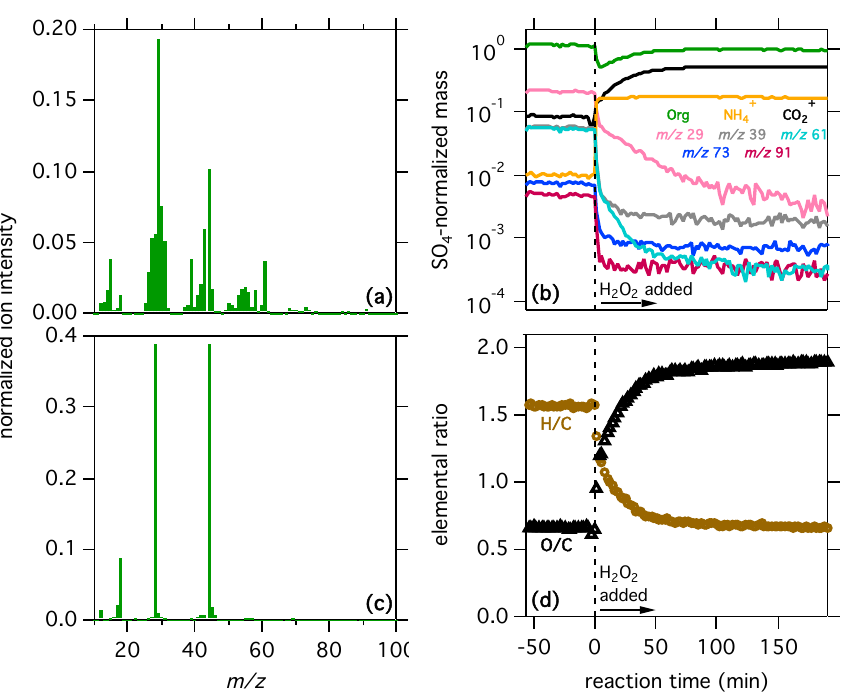
Figure 3. Results for the oxidation of erythritol within the bulk aqueous phase: (a) AMS spectra of unreacted erythritol; (b) sulfate- ) , CO + normalized mass concentrations of total organic (Org), ammonium (NH + , and key ions associated with erythritol ( m/z 29, 39, 4 2 61, 73, 91) as a function of reaction time; (c) AMS spectra of oxidation products; and (d) oxygen-to-carbon and hydrogen-to-carbon ratios as a function of reaction time. Results in (a, c, d) are from high-resolution mass spectrometric analysis. All traces in (b) are from unit mass resolution, except NH + and CO + , which are high-resolution 4 2